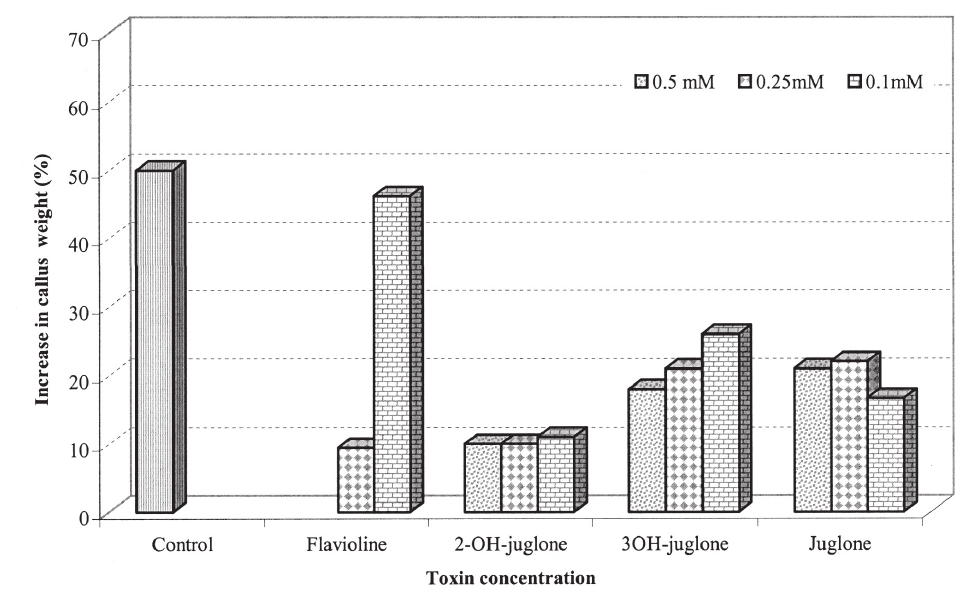
Fig. 3. Effect on the growth of grapevine cv. Gamay callus of the presence of different concentrations of naphthoqui- nones (2-OH-juglone and 3-OH-juglone) in comparison with flavioline and juglone. (Flaviolin was not tested at 0.5